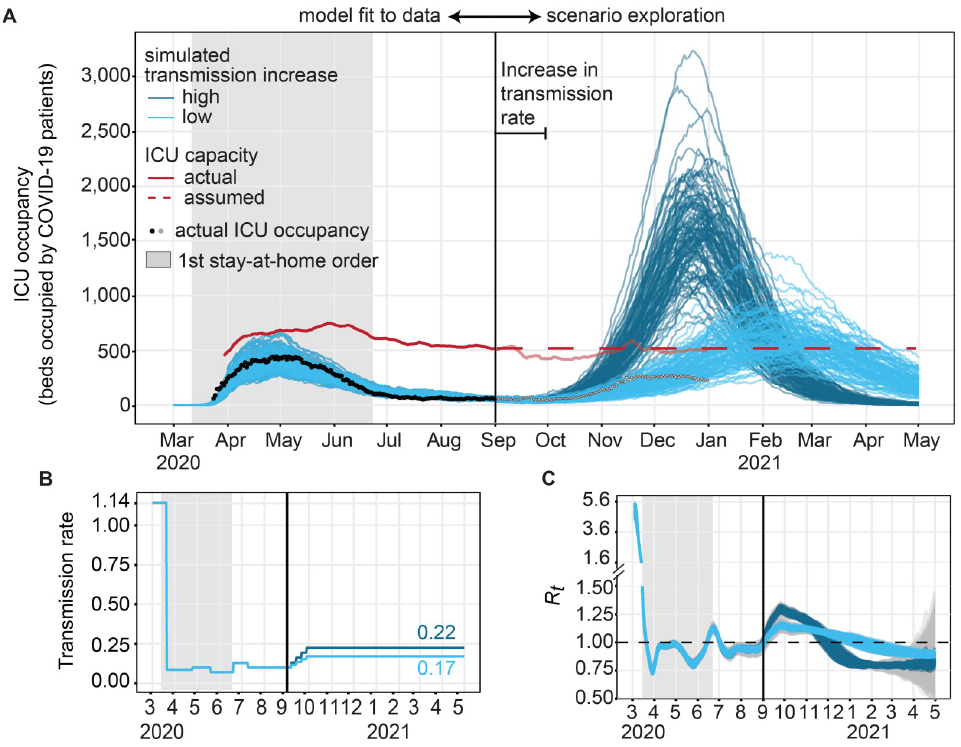
Fig 3. ICU occupancy over time, model fit, and increase in occupancy following an imposed increase in transmission. A) Predicted and observed daily ICU occupancy for Chicago in 2020. Black dots: actual COVID-19 ICU occupancy in Chicago. Red line: ICU bed capacity for COVID-19 patients, actual 7 day rolling average (solid) and model assumption (dashed) after September 2020. Blue lines: simulated trajectories under low (light blue) or high (dark blue) level of transmission increase and no triggered mitigation. The top 100 trajectories after fit to ICU census are shown (see Fig J in S1 Text for full sample). B) Transmission rate parameter, which was fit to data before September 1, 2020, and gradually increased until October 1, 2020, to a higher (dark blue) or lower (light blue) target value. C) R estimated from t simulated new infections with lines corresponding to median R t per trajectory and shaded grey area around lines the corresponding 95% confidence intervals obtained from the estimation method. The grey rectangle shows the time of the first stay-at-home order. In the fitting process, we first estimated the infection importation date (date with 10 infec- tions), initial transmission rate, and transmission rate under mitigation for March 2020. We then fitted twice-monthly adjustments to the transmission rate between April and August 2020. Other parameters were set to their mean value according to local data or epidemiological studies (Table B in S1 Text). Best fit parameter combinations were those that minimized the negative log likelihood of the simulated trajectories, based on a Poisson distribution. In the fitting, ICU census and med/surg census were weighted equally. The model fit was validated against COVID-19-like illness (CLI) hospital admissions data for Chicago hospitals and against COVID-19 deaths from I-NEDSS with Chicago listed as county or ZIP code of residence. To account for parameter uncertainty, we ran simulations with 400 unique parameter combinations sampled from uniform distributions using data-informed parameter ranges. We then chose 100 trajectories (unique set of parameters) that best fit the ICU census data and used these parameter sets in the later analysis. To describe the fitting accuracy, we calculated the mean absolute error (MAE) [41], using the metrics R package [42], for the median prediction compared against the weekly moving average of the data (Fig G in S1 Text). The median Rt estimates per trajectory (unique set of parameters) were aggregated per scenario using mean and 90% prediction interval.